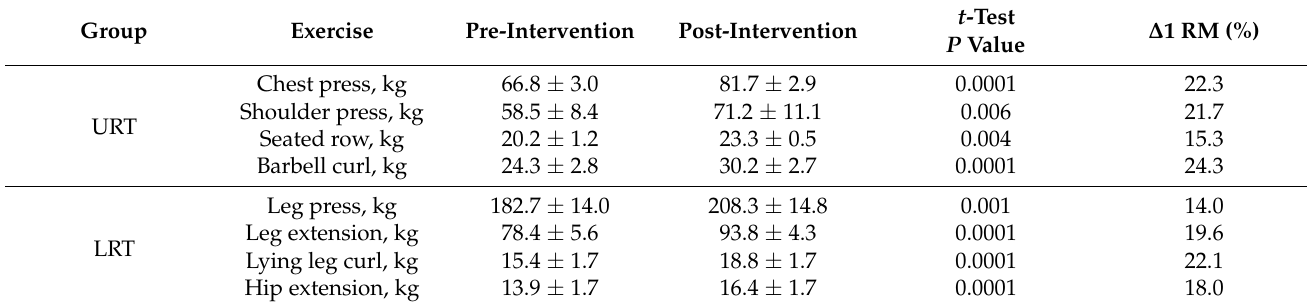
Table 2. Changes in maximal strength (1 RM) after resistance training.